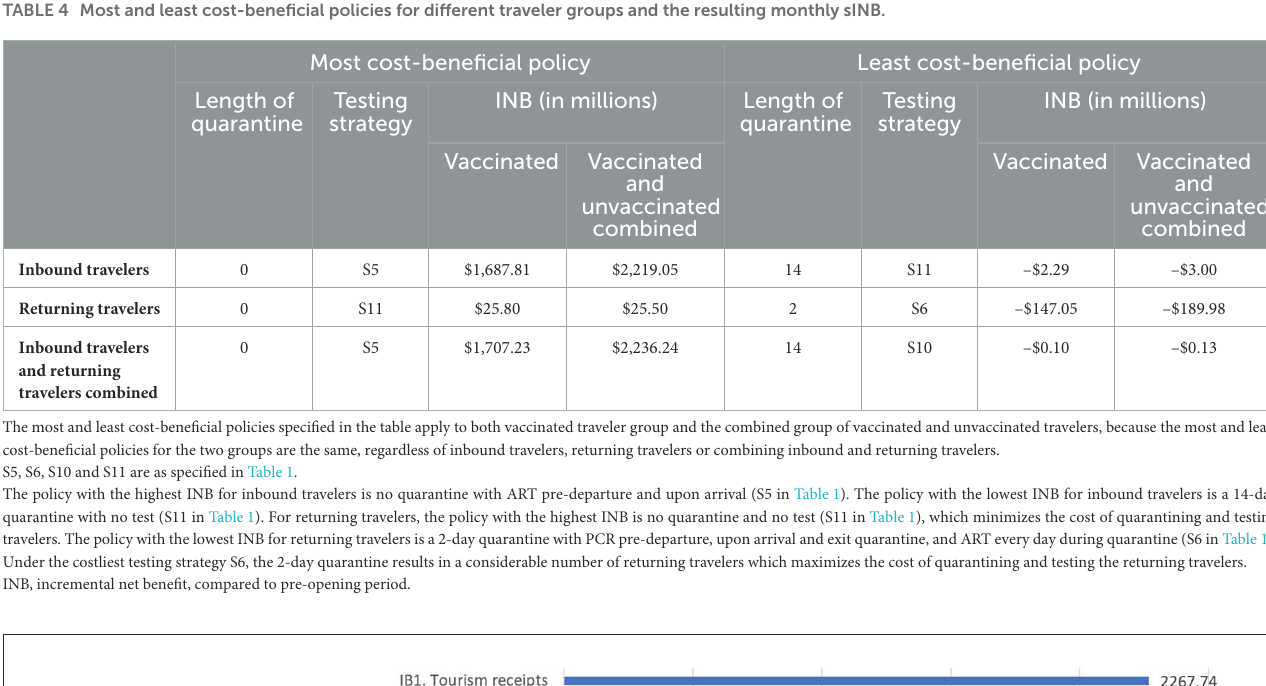
TABLE 4 Most and least cost-beneficial policies for different traveler groups and the resulting monthly sINB.